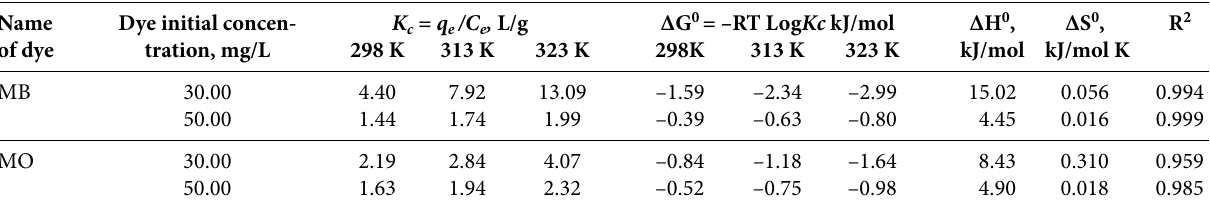
Table 4. Thermodynamic parameters of MB and MO onto GCM at pH 8.0 for MB and pH 6.0 for MO, 2.0 g/L dosage and180 min equilibrium time in the range of temperature, 298–323 ± 0.5 K (n = 3, the reported values are mean of three